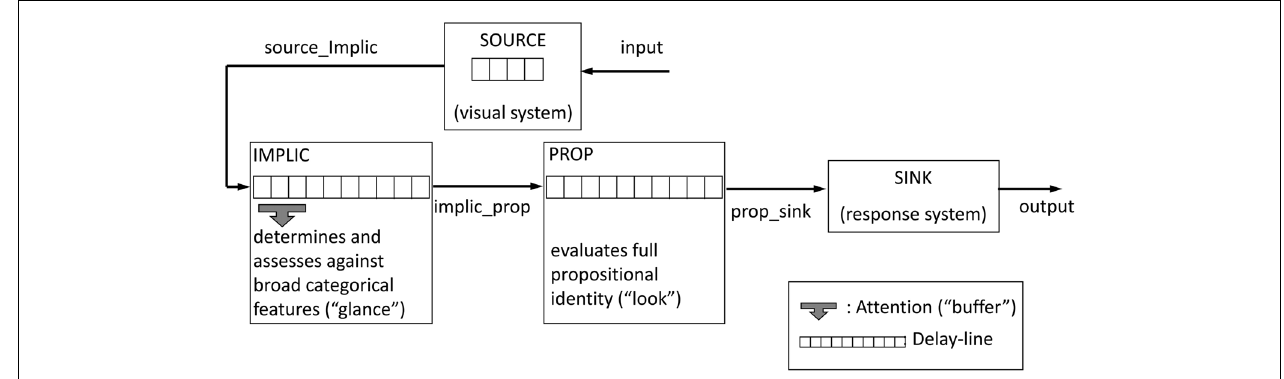
FIGURE 3 |Top-level structure of the glance–look model with Implic attended (buffered).